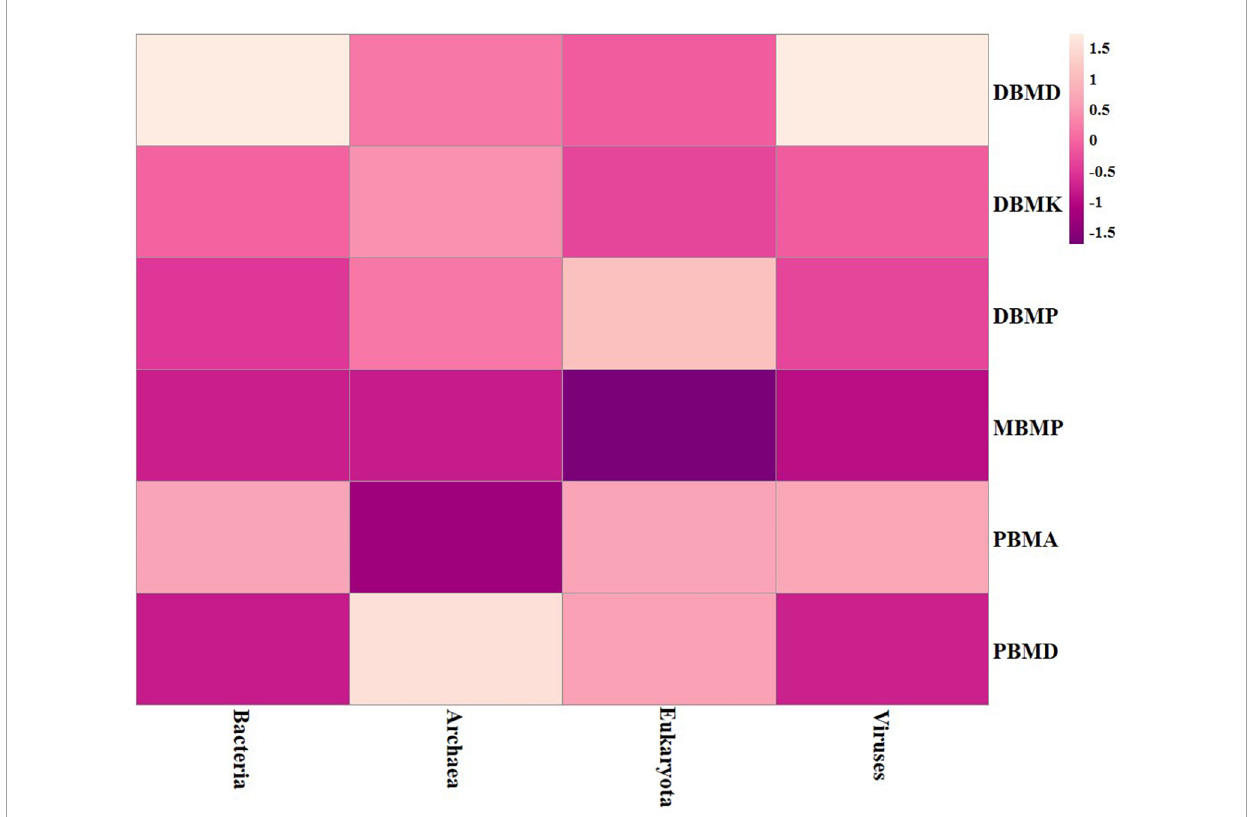
FIGURE1 Heat map representation of major domain in moiya pangsung, mileye amileye, moiya koshak, and midukeye .